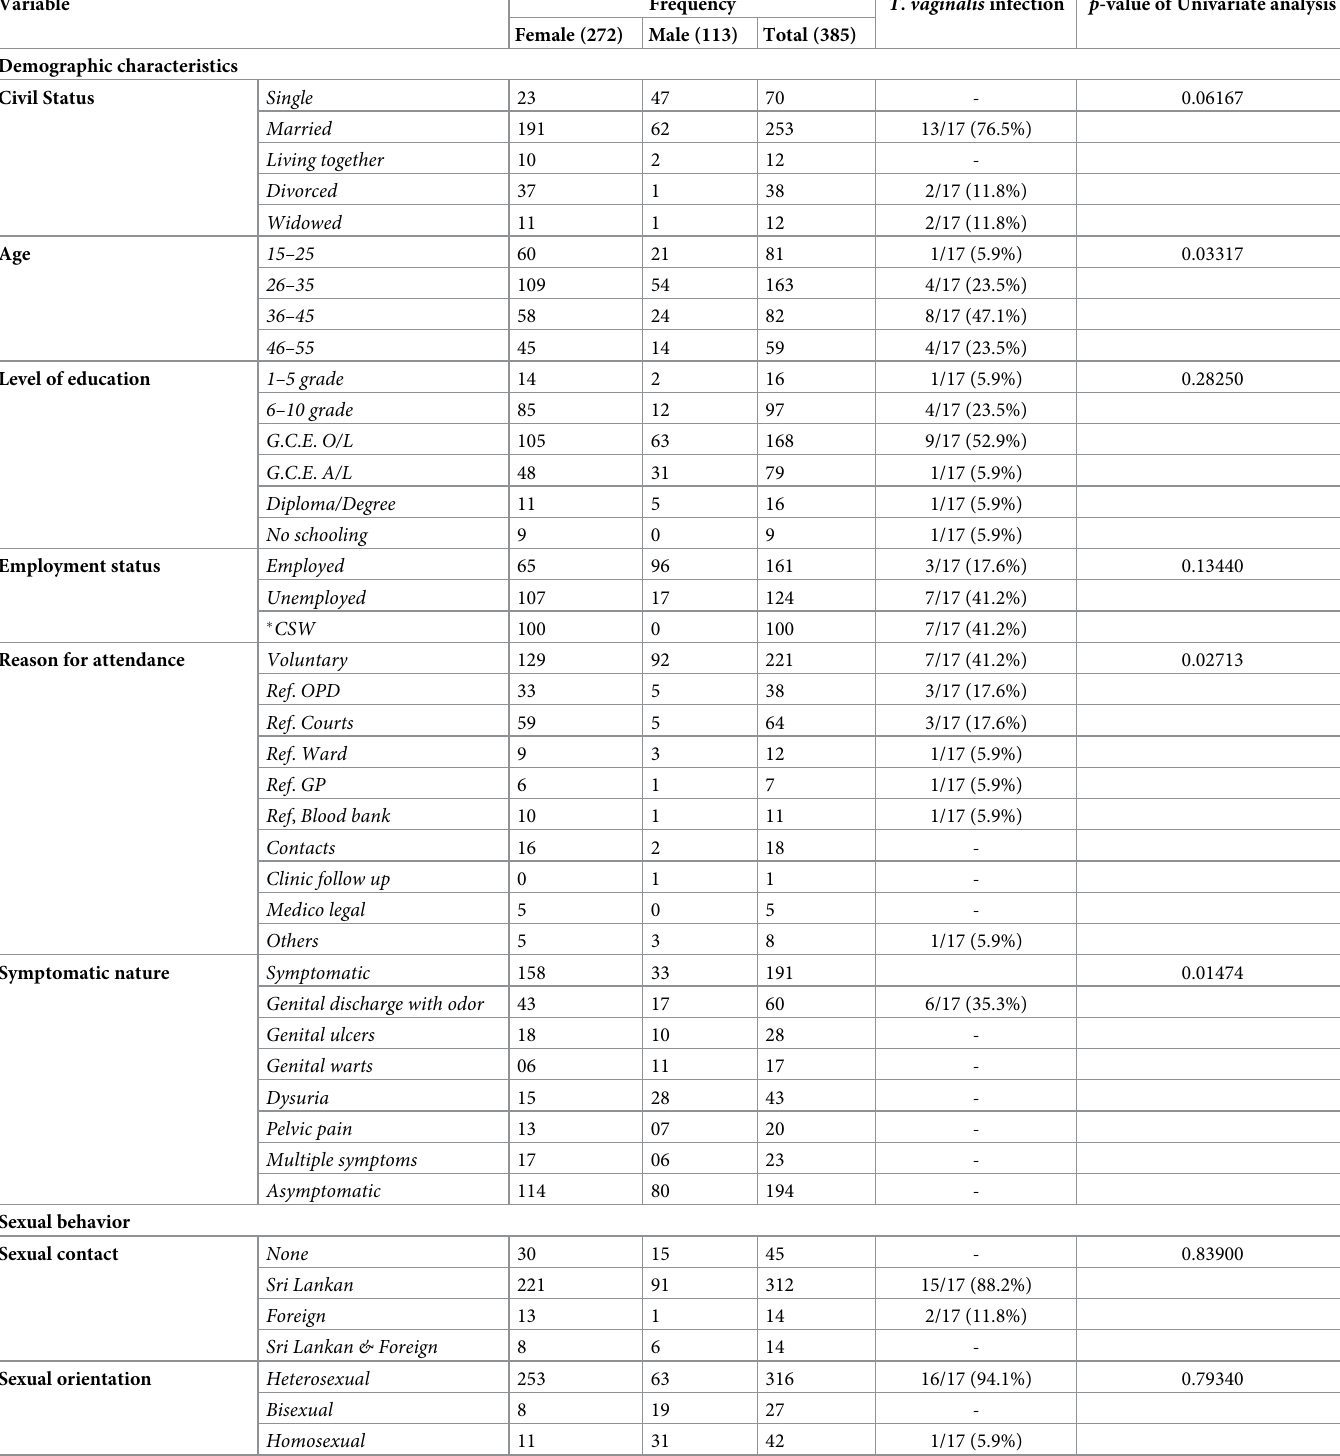
Table 5. Demographic characteristics and sexual behavior of patients and the association and prevalence of trichomoniasis.